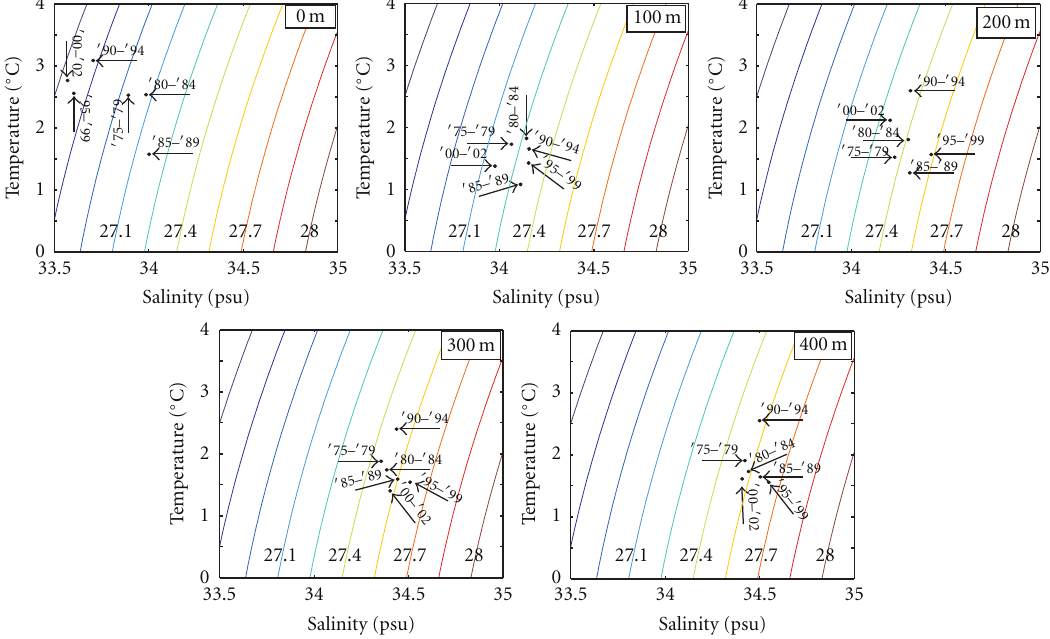
Figure 2: T-S diagrams at all depths during austral summer from 1975 to 2002. The data were averaged for 5-year periods: 1975–1979,